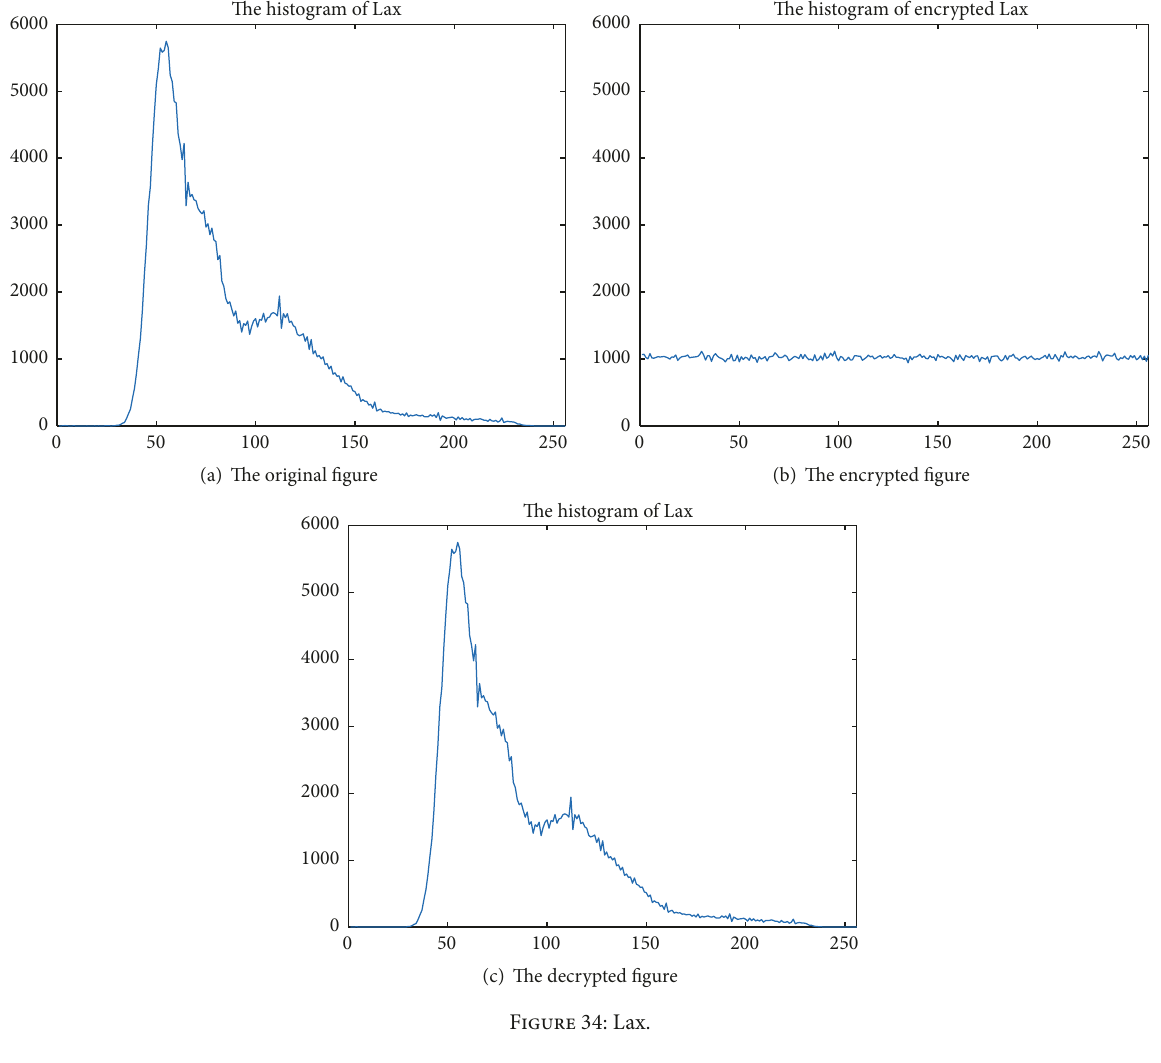
Table 13: NPCR and UACI between cipher-images with slightly different plain-images. Image